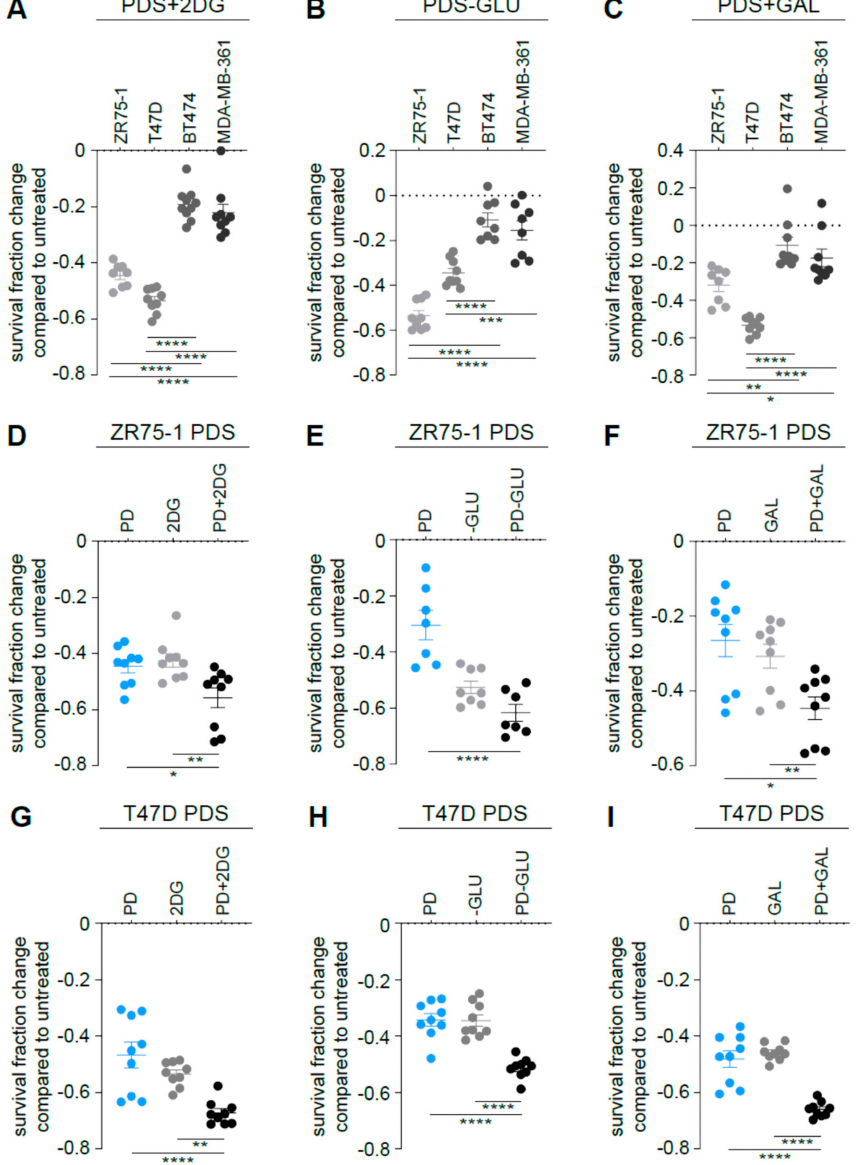
Figure 6. Targeting glycolysis potentiates palbociclib e ff ects on ER + / HER2 − parental cells. PDS cells were either treated for 3 days in the presence of 2-DG ( A ), glucose-deprived medium ( B ) or in a medium in which glucose is replaced by galactose ( C ). Data are presented as fold change survival fraction of treated versus vehicle-treated or basal-cultured cells. Each dot represents at least three technical replicates from three biological